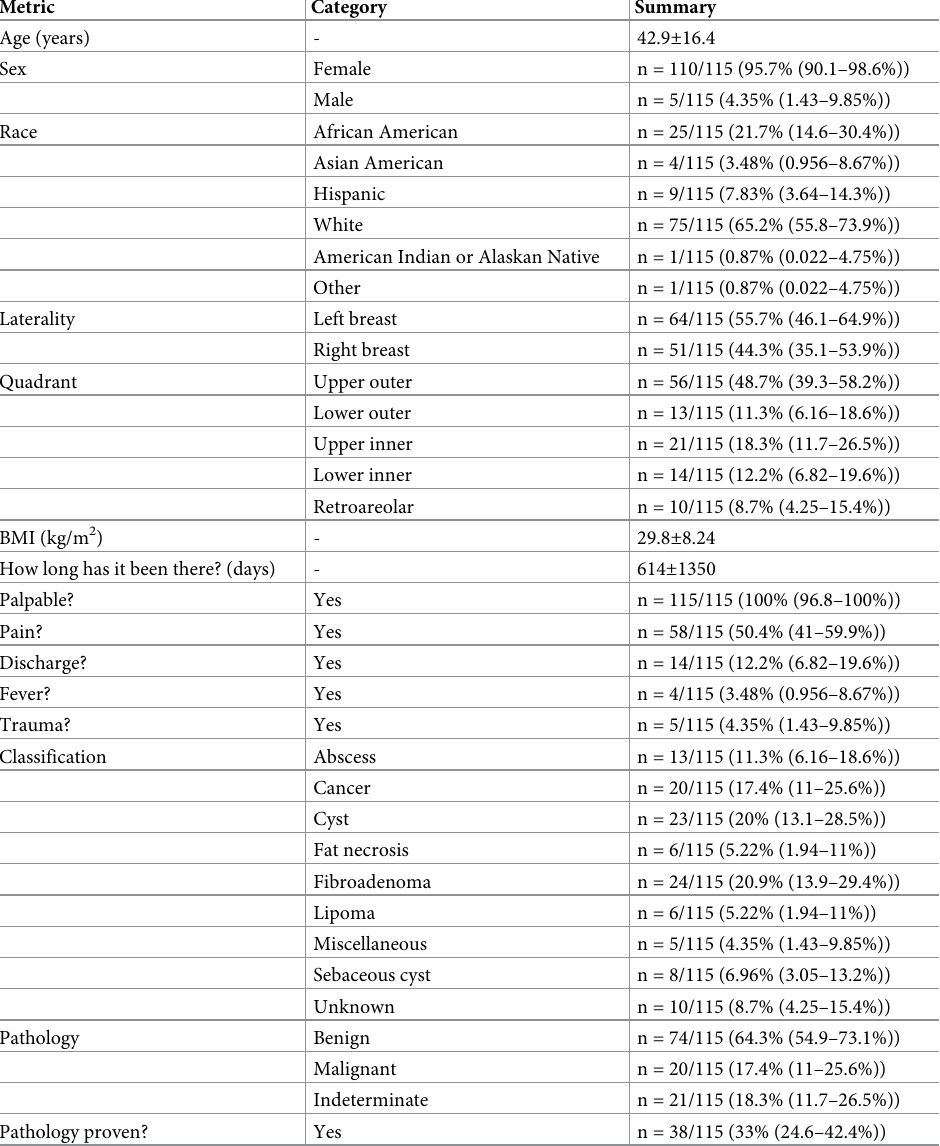
Table 1. Subject demographics and mass classifications. Categorical variables are summarized as n (proportion (95% CI)), while continuous variables are summarized as mean ± standard